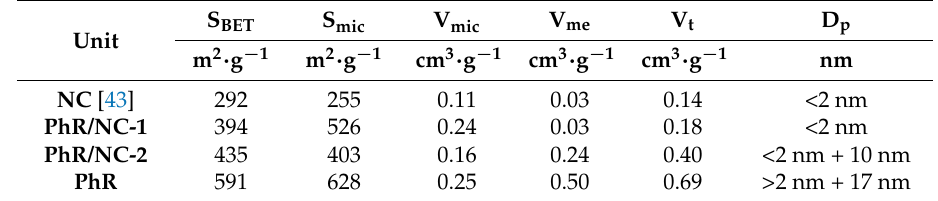
Table 2. Textural characteristics of carbon materials determined from nitrogen sorption isotherms.